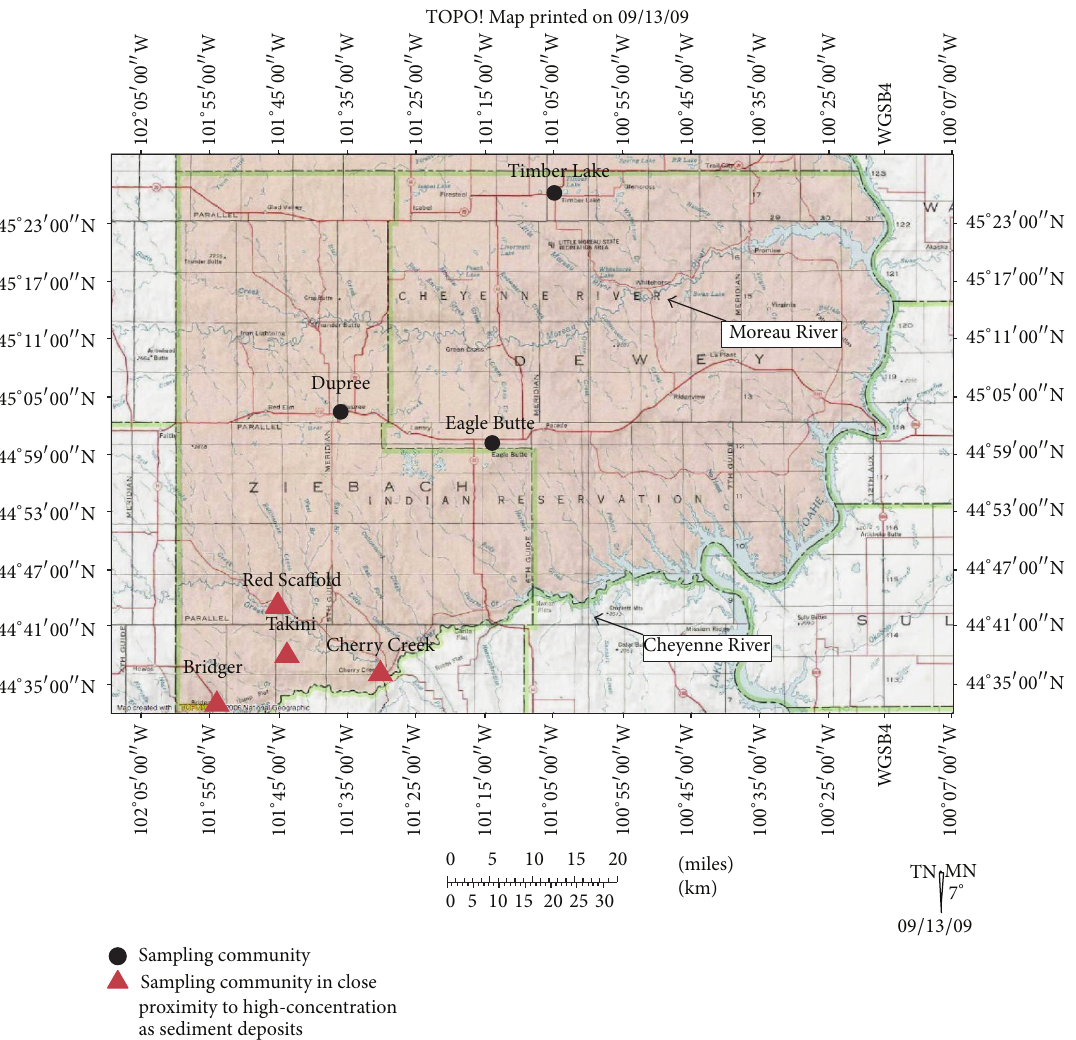
Figure 1: Map of Cheyenne River Sioux Tribal lands and sampling